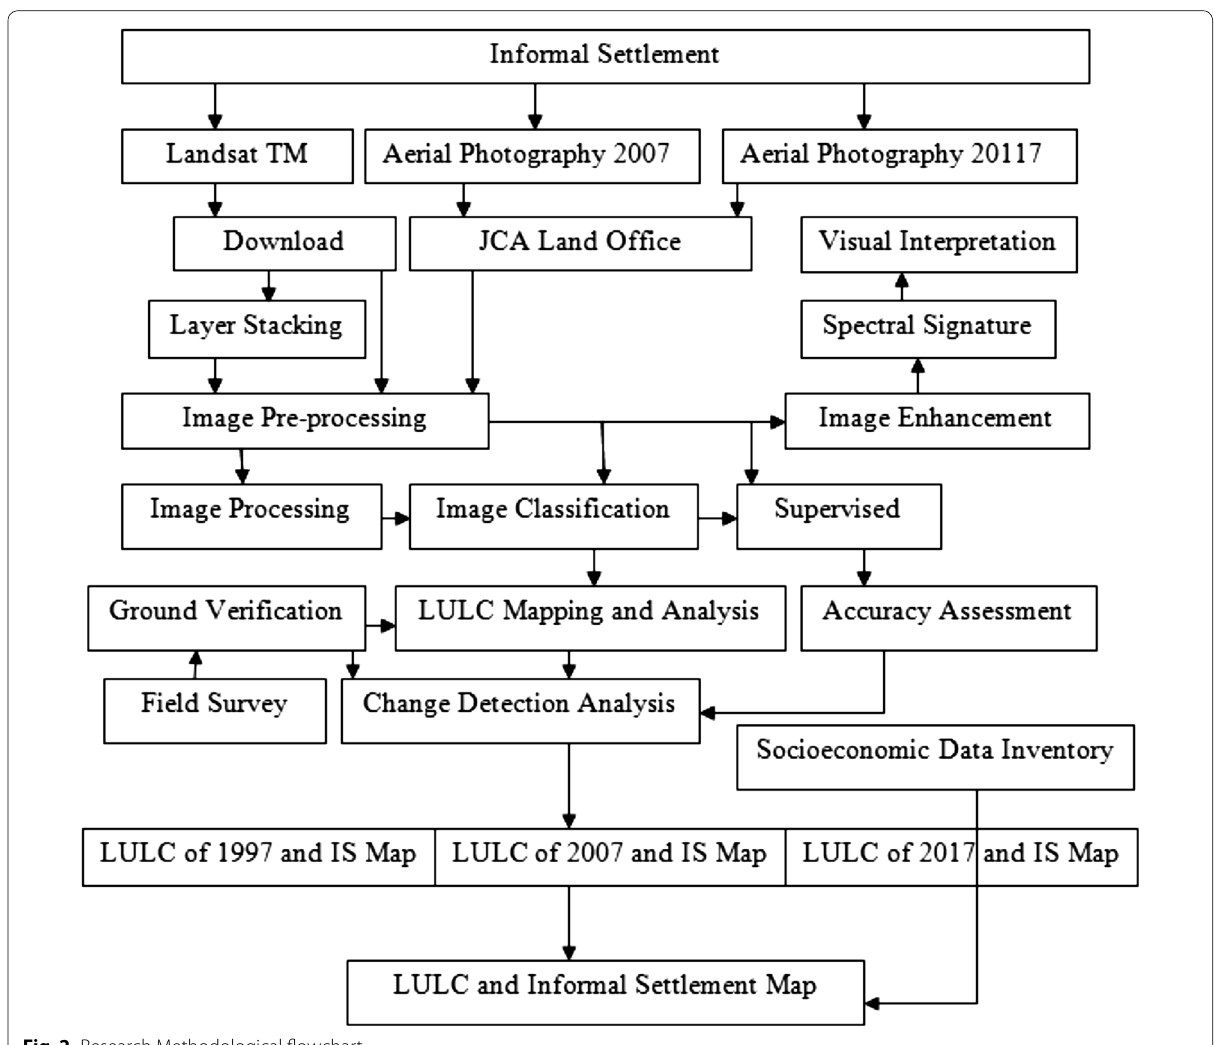
Fig. 2 Research Methodological flowchart